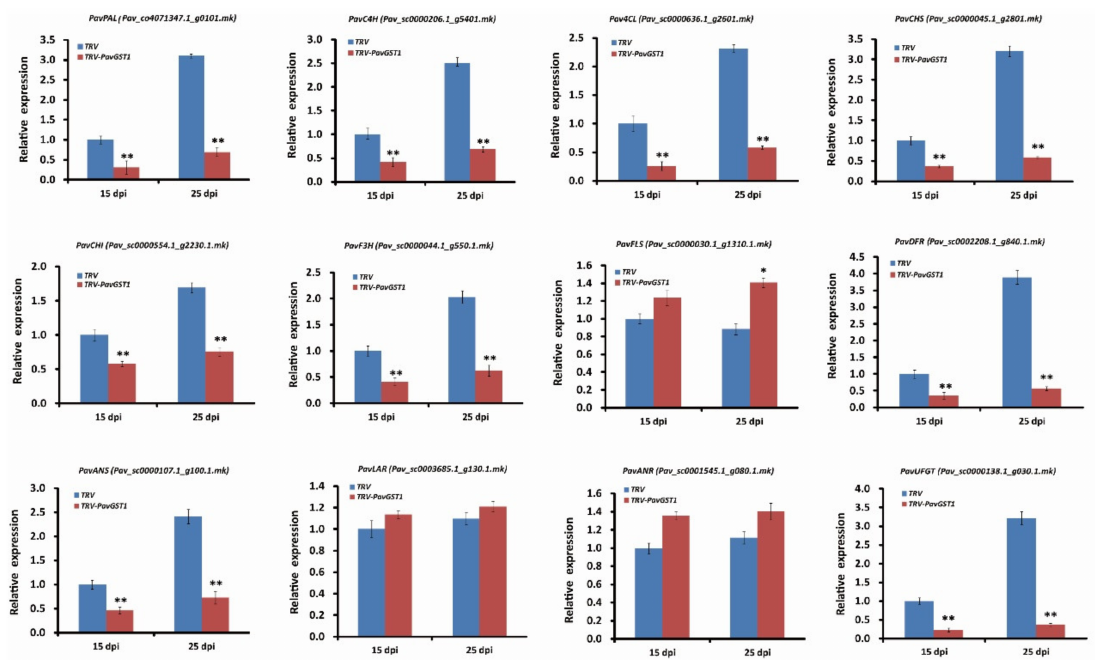
Figure 4. Transcript levels of anthocyanin pathway genes PavPAL , PavC4H , Pav4CL , PavCHS , PavCHI , PavF3H , PavFLS , PavDFR , PavANS , PavLAR , PavANR , and PavUFGT in PavGST1-silenced sweet cherry fruits and control fruits at 15 and 25 dpi. PAL, phenylalanine ammonia lyase; C4H, cinnamate 4-hydroxylase; 4CL, 4-coumarate-CoA ligase; CHS, chalcone synthase; CHI, chalcone isomerase; F3H, flavanone 3-hydroxylase; FLS, flavonol synthase; DFR, dihydroflavonol 4-reductase; ANS, anthocyanidin synthase, LAR, leucoanthocyanidin reductase; ANR, anthocyanidin reductase; UFGT, UDP-glucose:flavonoid-3-O-glucosyltransferase. Values are means ± SD from six independent replicates. Significant differences among means were determined by one-way analysis of variance (ANOVA, *, p < 0.05, **, p <